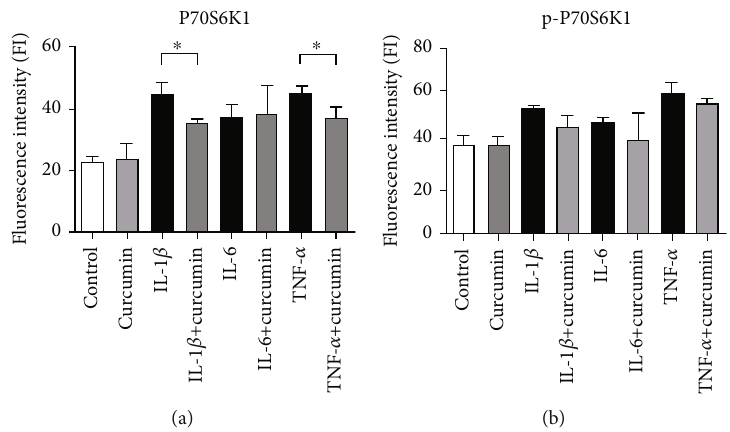
Figure 7: Bars represent densitometry analysis from confocal microscopy evaluation of P70S6K1 and its phosphorylated form. Statistical signi fi cance was measured by Dunn ’ s test, ∗ p ≤ 0 : 05 , ∗∗ p ≤ 0 : 01 . Results indicated statistical signi fi cance between curcumin and IL-1 β and TNF- α SW982-treated cells in the levels of unphosphorylated protein.